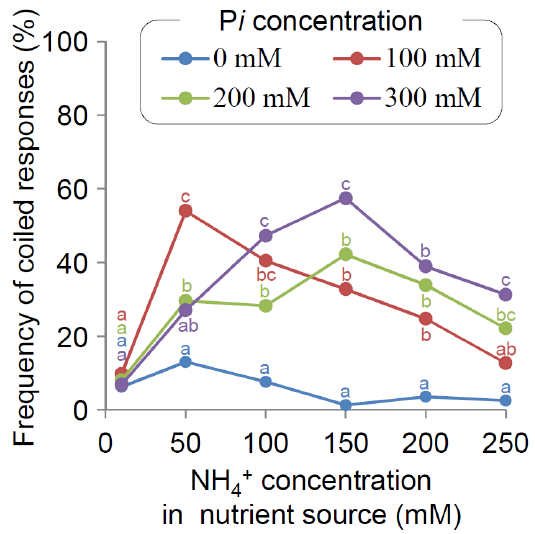
Figure 4. Effect of the interaction of NH 4+ and P i on the nutritropic response of the main roots of WRC 25. Frequencies of the coiled responses in the main roots of WRC 25 were determined in the nutritropic bioassays ( n = 71–181 per each condition) with nutrient sources containing NH 4+ and P i at the indicated concentrations. Data of 200 mM NH 4+ and 200 mM P i were the same as those in Figure 2. Statistical significance among conditions at the same concentrations of NH 4+ was tested using Fisher’s exact test with multiple testing corrections (Holm correction). Different letters indicate a significant difference at p < 0.05.